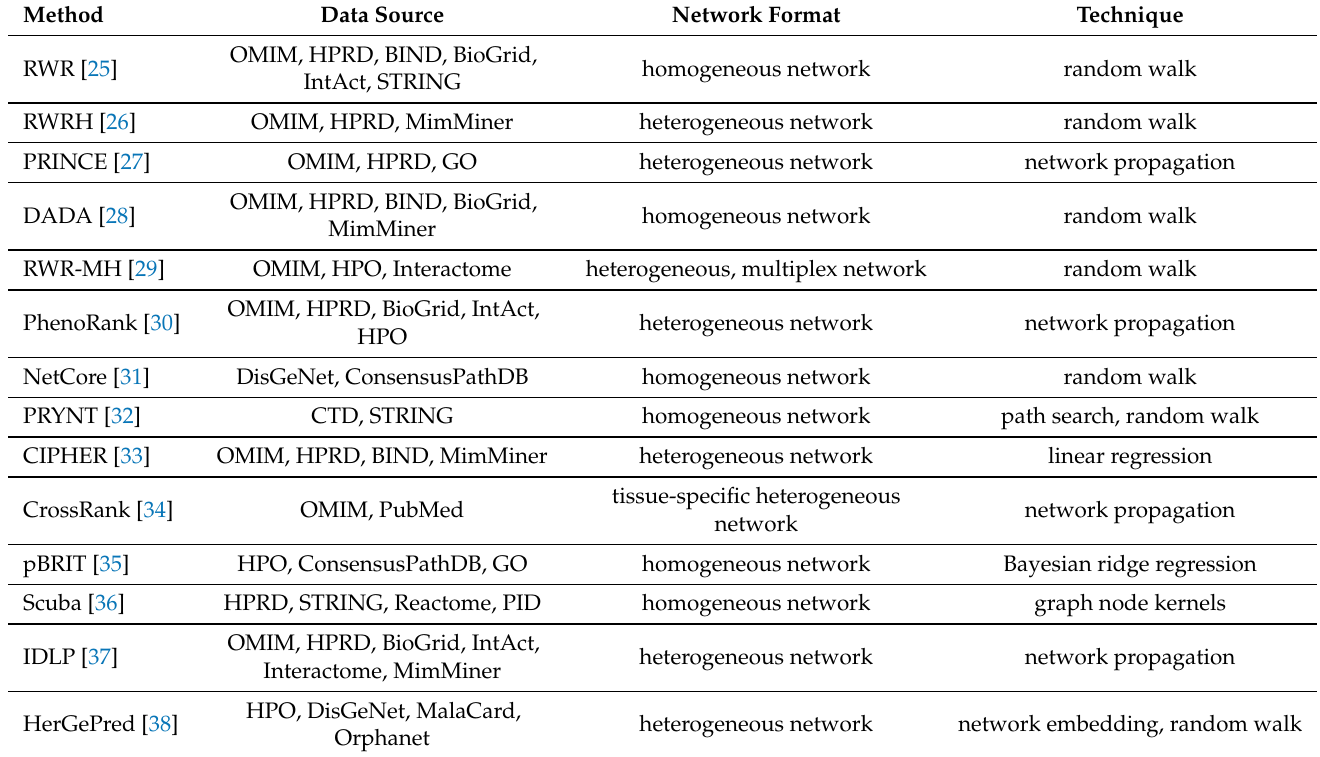
Table 1. List of network-based methods for disease-gene association prediction including data sources, input network type, and key